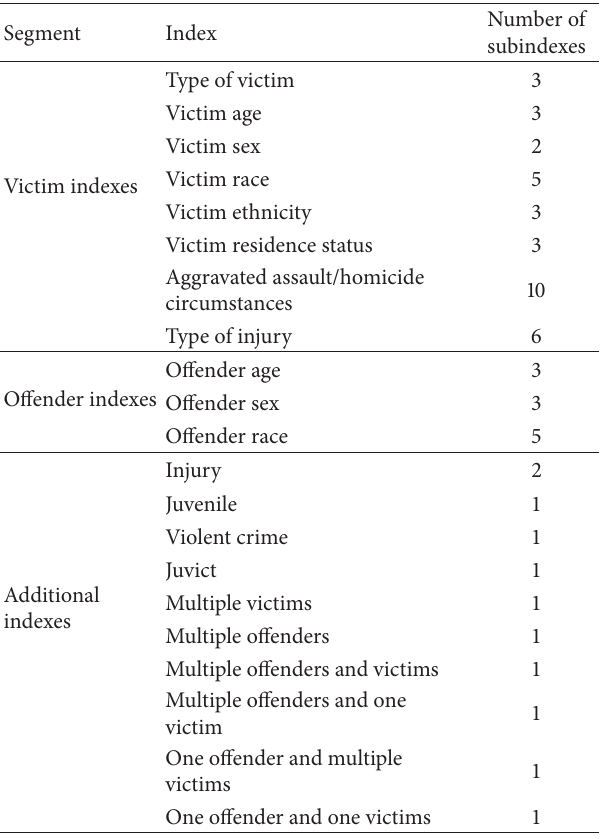
Table 1: NIBRS indexes